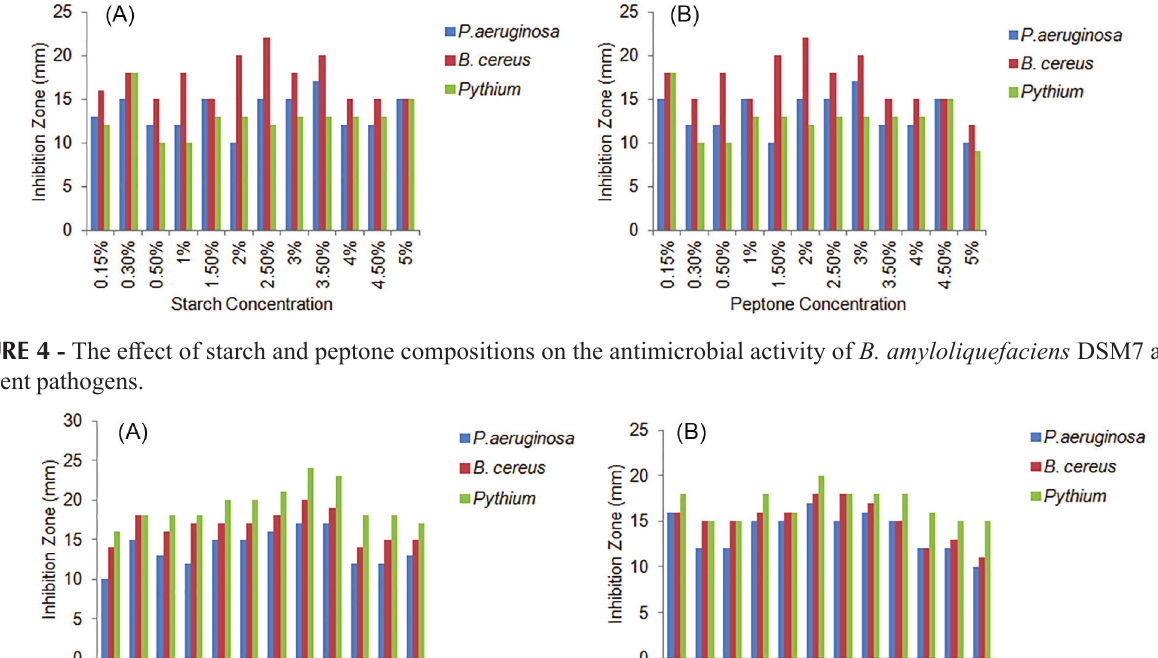
FIGURE 3 - The effect of carbon and nitrogen sources on the antimicrobial activity of the endophytes against B. cereus , P. aeruginosa , and Pythium (A) B. amyloliquefaciens DSM7 (B) B. subtilis subsp. subtilis str. 168